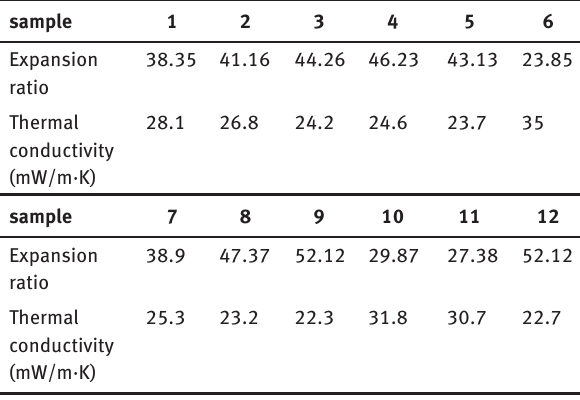
Table 2: Relationship between the thermal conductivity and expansion ratio of the of PS-MCF